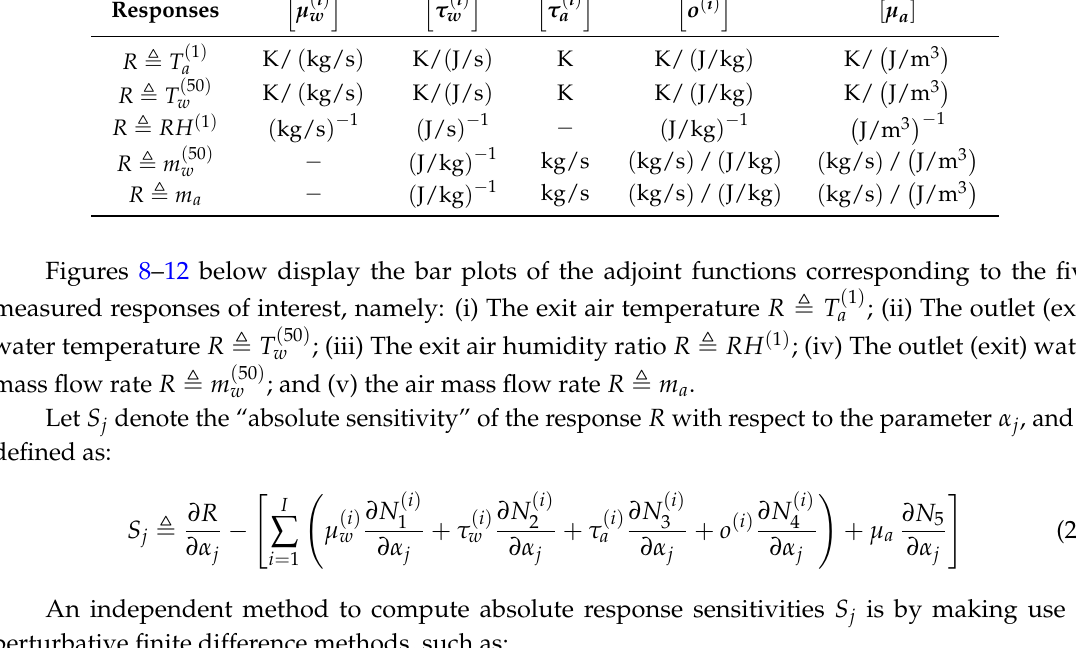
( 1 ) (cid:44) T ( 50 ) a , R w , ( 1 ) ( 50 ) a denotes exit air temperature; T w ( 50 ) w denotes exit water